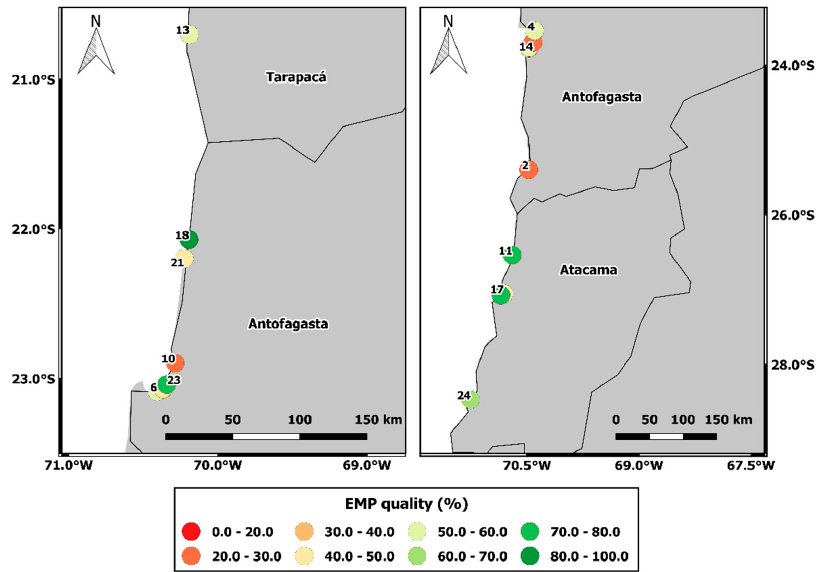
Figure 7. EMP quality assessed based on the distribution of desalination projects in Northern Chile.